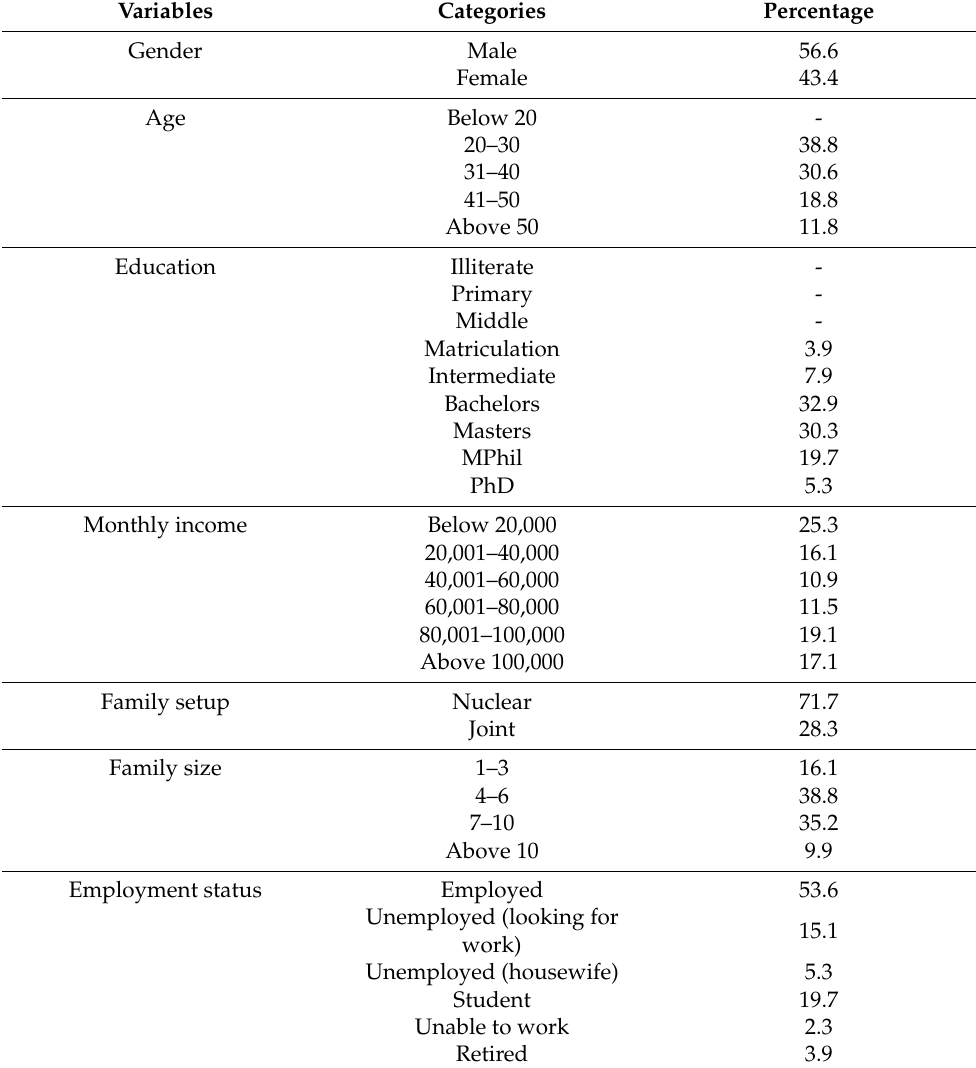
Table 1. Demographic statistics of the